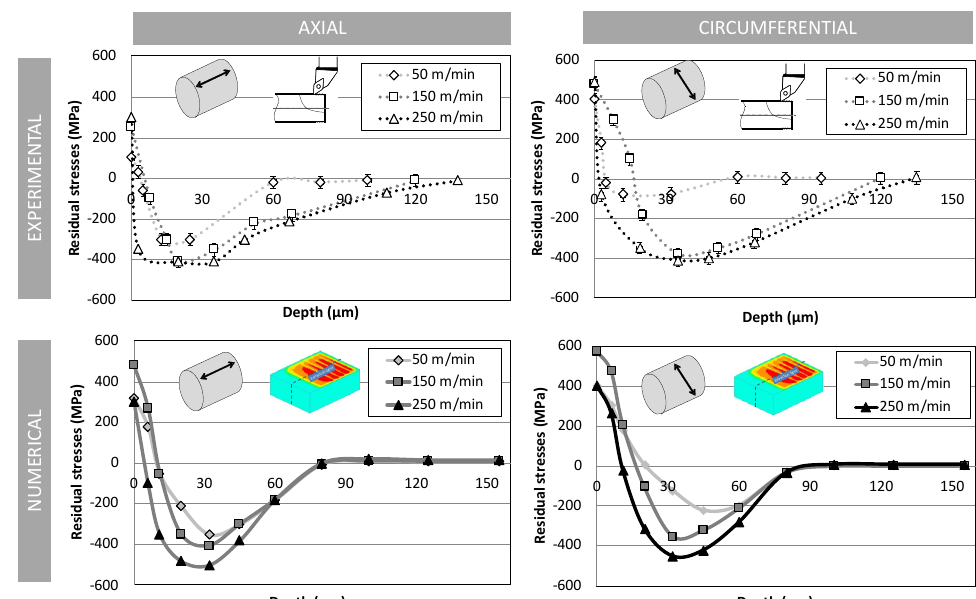
Figure 9. Effect of cutting speed on residual stresses.